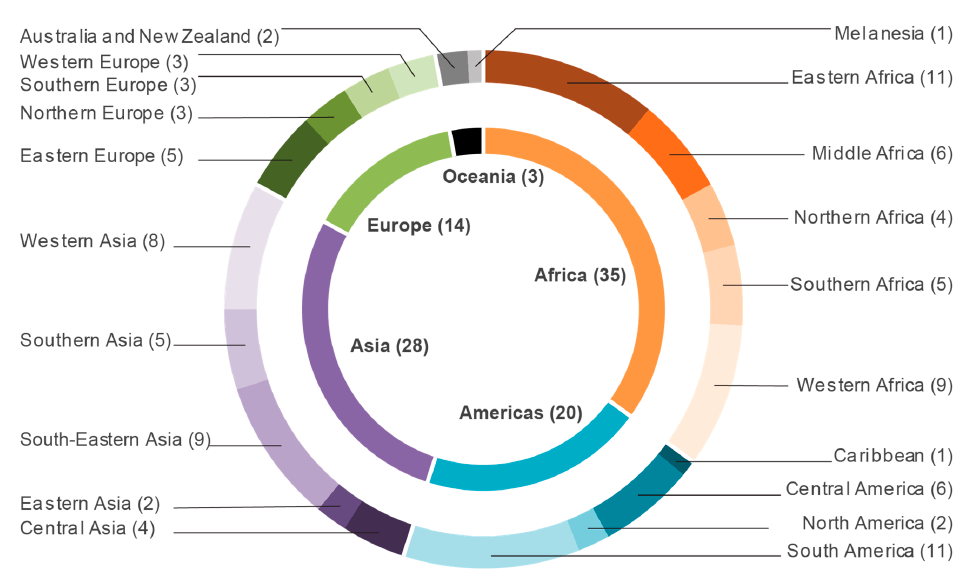
Figure 1. The sample by continents and regions.